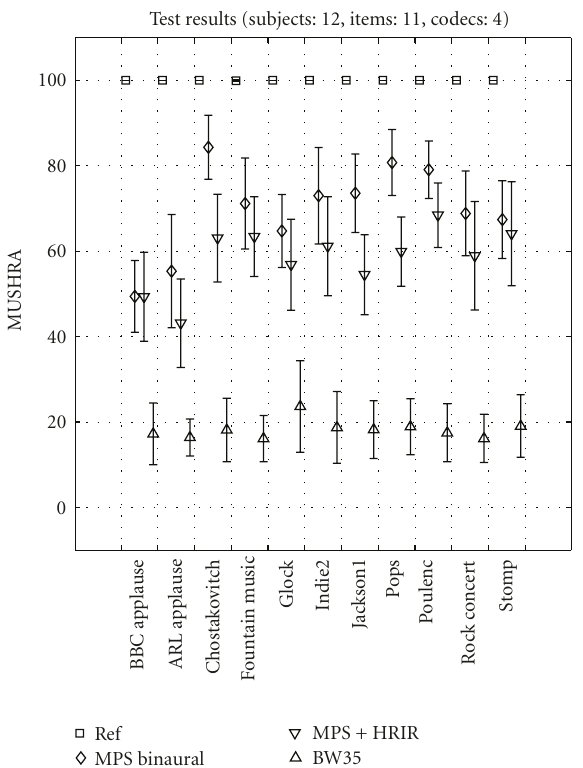
Figure 7: Subjective test results averaged across subjects for the parametric approach. Error bars denote the 95% confidence intervals of the means.